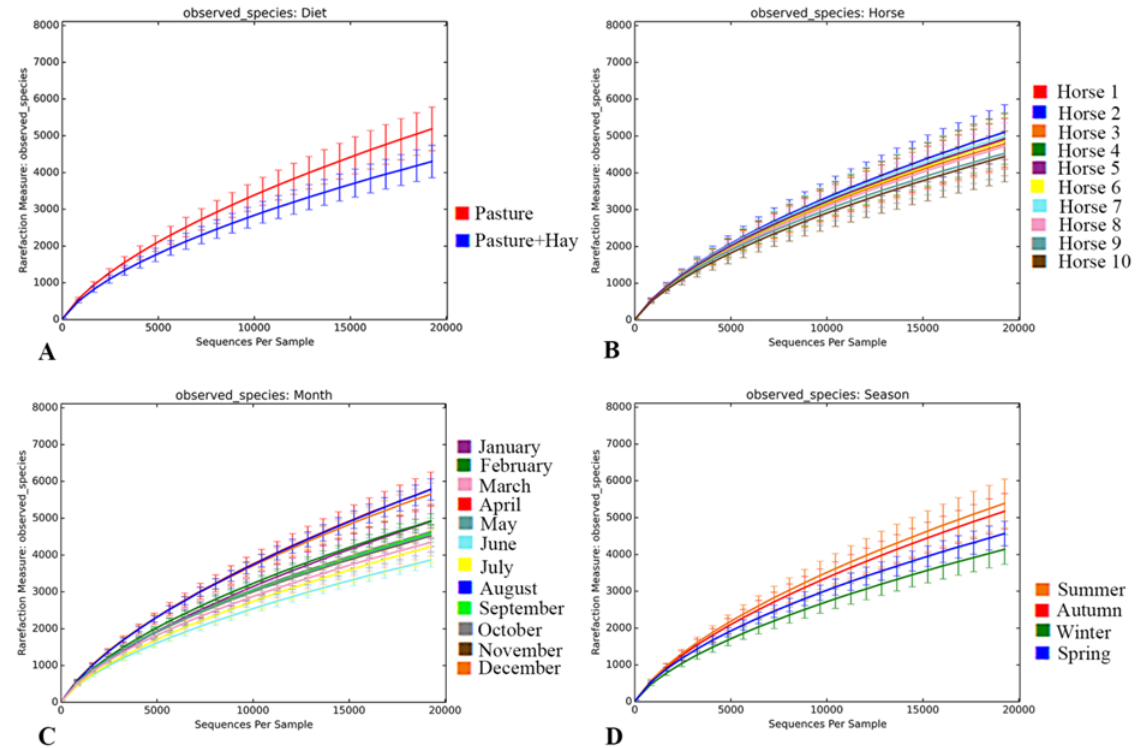
Figure 1. Alpha rarefaction curves illustrated by diet, horse, month, and season. Each rarefaction curve was generated